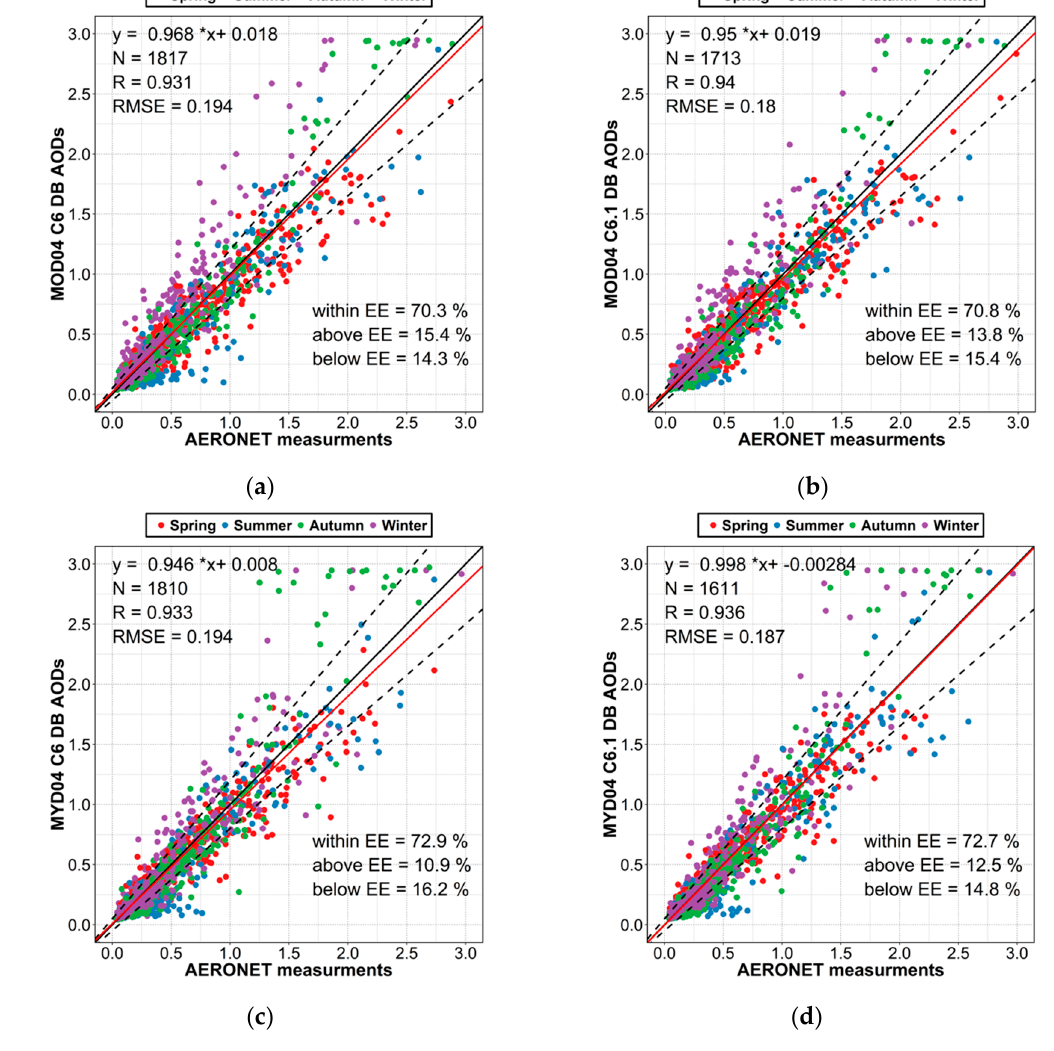
Figure 10. Validation of the MODIS-Terra (MOD04) C6 DB ( a ) and MOD04 C6.1 DB ( b ) AODs for the years, 2001–2016, and MODIS-Aqua (MYD04) C6 DB ( c ) and MYD04 C6.1 DB ( d ) AODs for the years, 2002–2016, against AERONET AODs. The red line is the regression line, the black solid line is the 1:1 line, and the black dashed lines indicate the envelope of the EE.